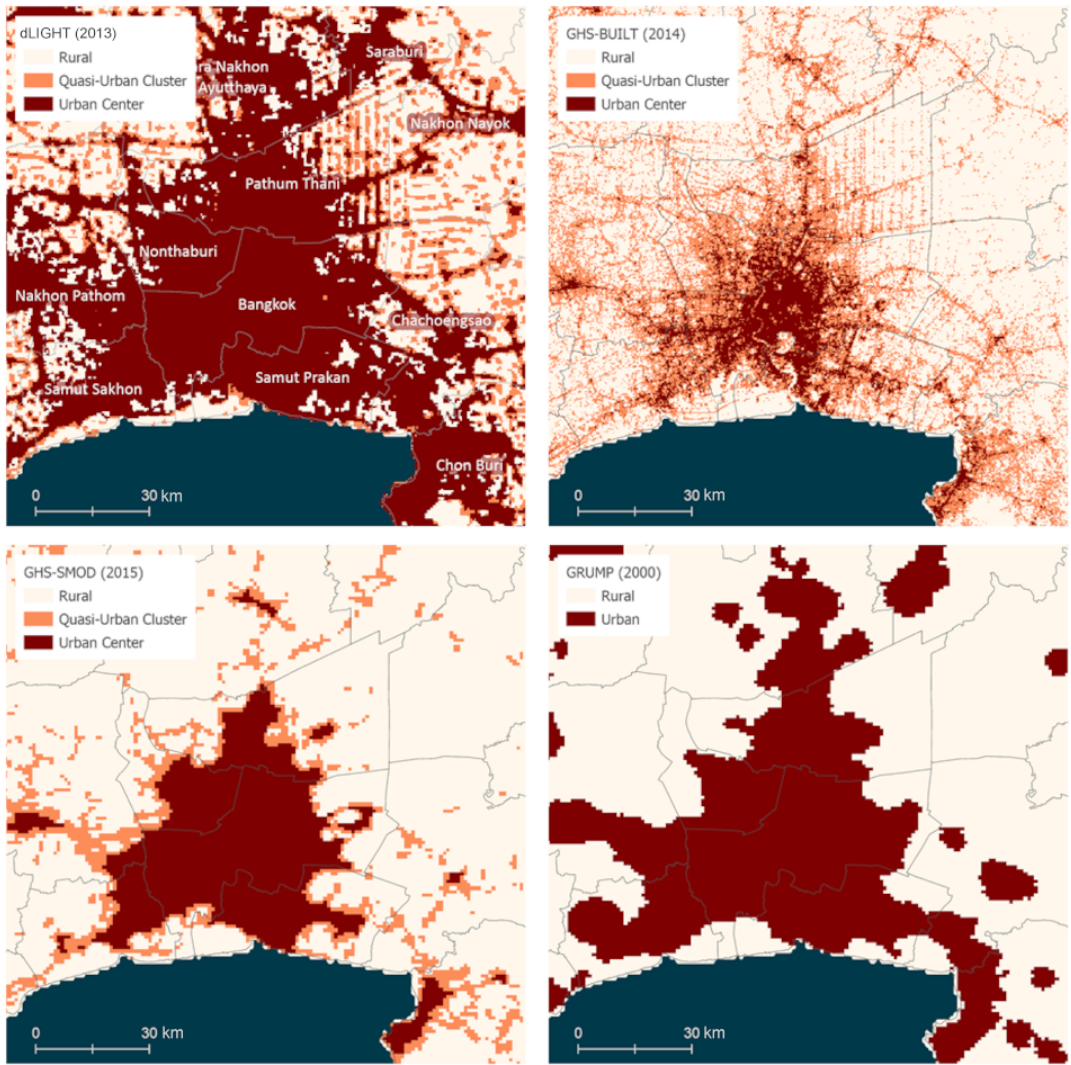
Figure 7. Urban-proxy data classified into urban, quasi-urban and rural, Bangkok and surrounding areas, Thailand. Note that the dark blue indicates ocean, and gray boundaries indicate first-order administrative